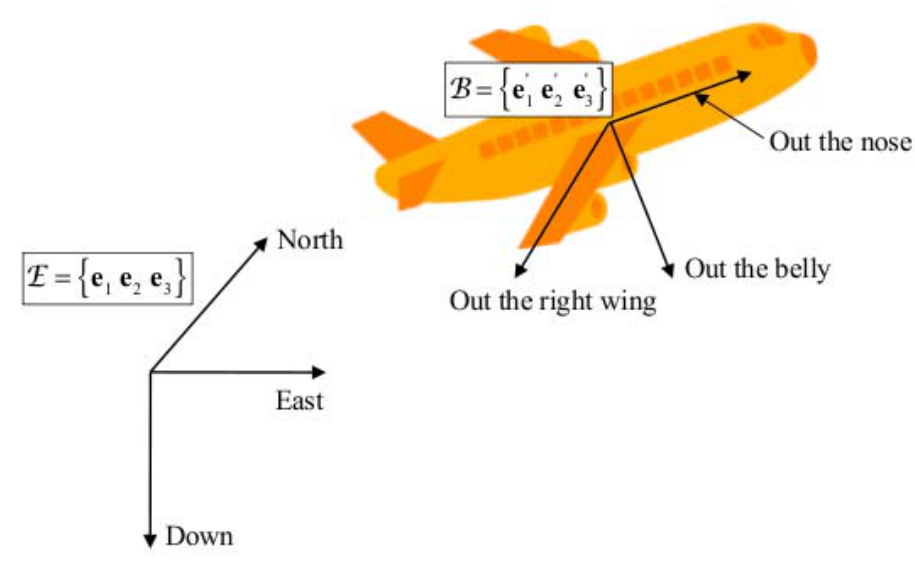
Figure 1. Earth-fixed frame and body-fixed frame on a toy